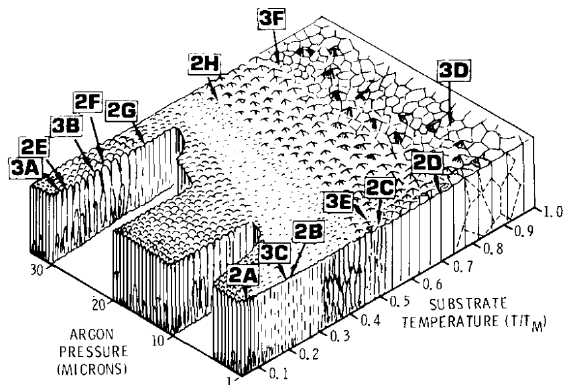
Figure 5. Schematic representation of dependence of coating structure on substrate temperature and argon pressure for sputter deposition, that is representative of most achievable thin film morphologies by other methods, but not necessarily in the same parameter space. The number-letter codes describe the different morphologies in detail in the source communication. Reprinted from Thornton A.J., Influence of apparatus geometry and deposition conditions on the structure and topography of thick sputtered coatings, J. Vacuum Sci. Technol. 1974 , 11, 666; DOI: 10.1116/1.1312732 with the permission of AIP Publishing.